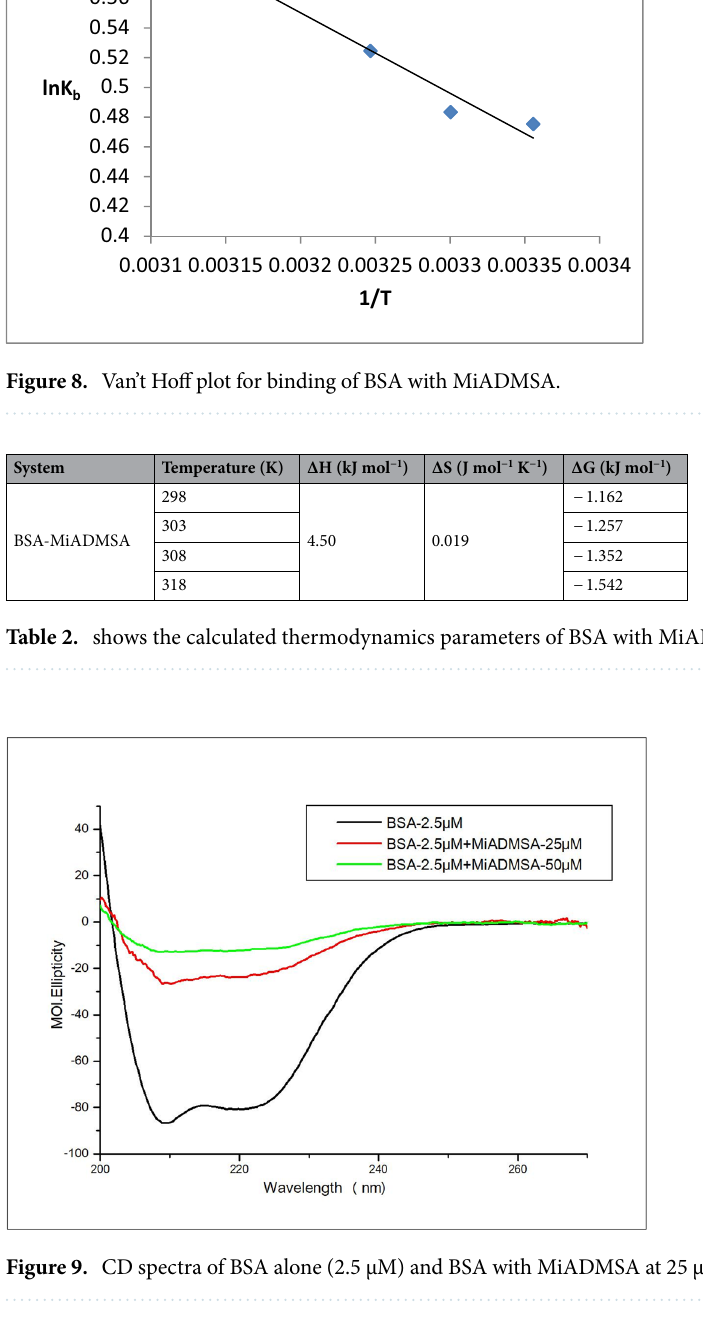
change, the hydrophobic cavities get exposed and the microstructures around the aromatic amino acid residues were disturbed. The conformational changes of BSA upon successive addition of MiADMSA were evaluated using CD spectroscopy. Figure 9 depicted the CD spectra of BSA alone (2.5 µM) and in the presence of MiADMSA at 25 µM and 50 µM concentration. We found that adding 25 µM concentrations of MiADMSA in BSA causes sig- nificant changes in both the peaks. Further, the double concentration of MiADMSA (50 µM) led to more changes in the peaks. This indicates the binding of MiADMSA induced conformational change in the secondary structure of BSA in terms of α helix, sheet, and turn as shown in Table 3. The CD spectrum of BSA alone has shown helicity of 56.8% which was changed to 50.8% at 1:10 ratio of BSA:MiADMSA inferred that in presence of MiADMSA, β helical structure of the protein was disrupted. Further addition of 50 µM of MiADMSA in BSA causes significant changes in helical content and changed in sheet content also. This indicates the binding of MiADMSA induced con- formational change in the secondary structure of BSA as shown in Table 3. Due to this conformational change, the